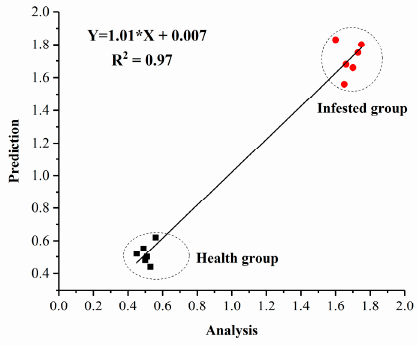
Figure 7. The regression curve of unknown vs known tomato plants based on sensors response.